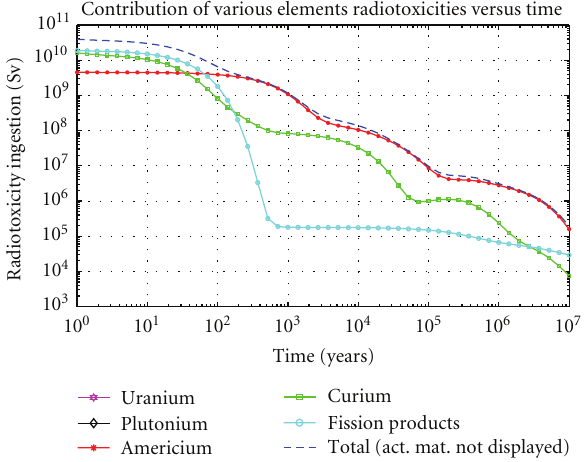
Figure 24: Contributions to radiotoxicity versus time—GCFR SNF end sixth cycle.